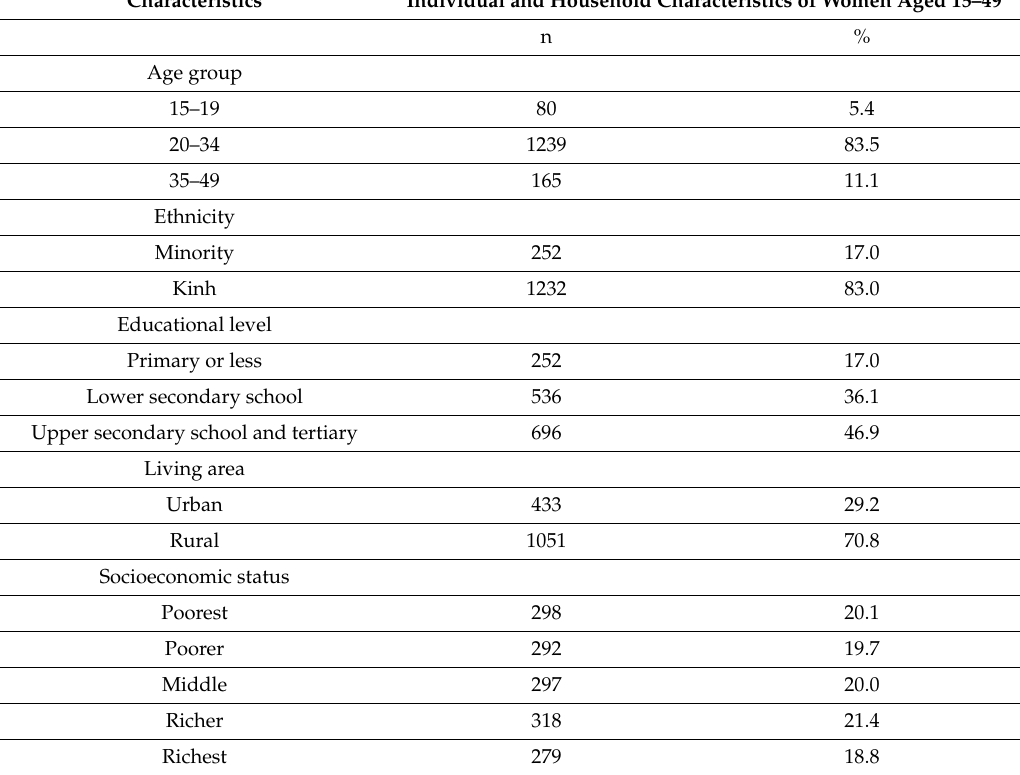
Table 1. Individual and household characteristics of women aged 15–49 had a live birth in the last two years, Vietnam, Multiple Indicator Cluster Survey (MICS) 2014.